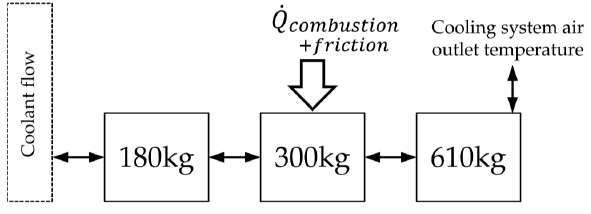
Figure 10. Three thermal masses engine model.